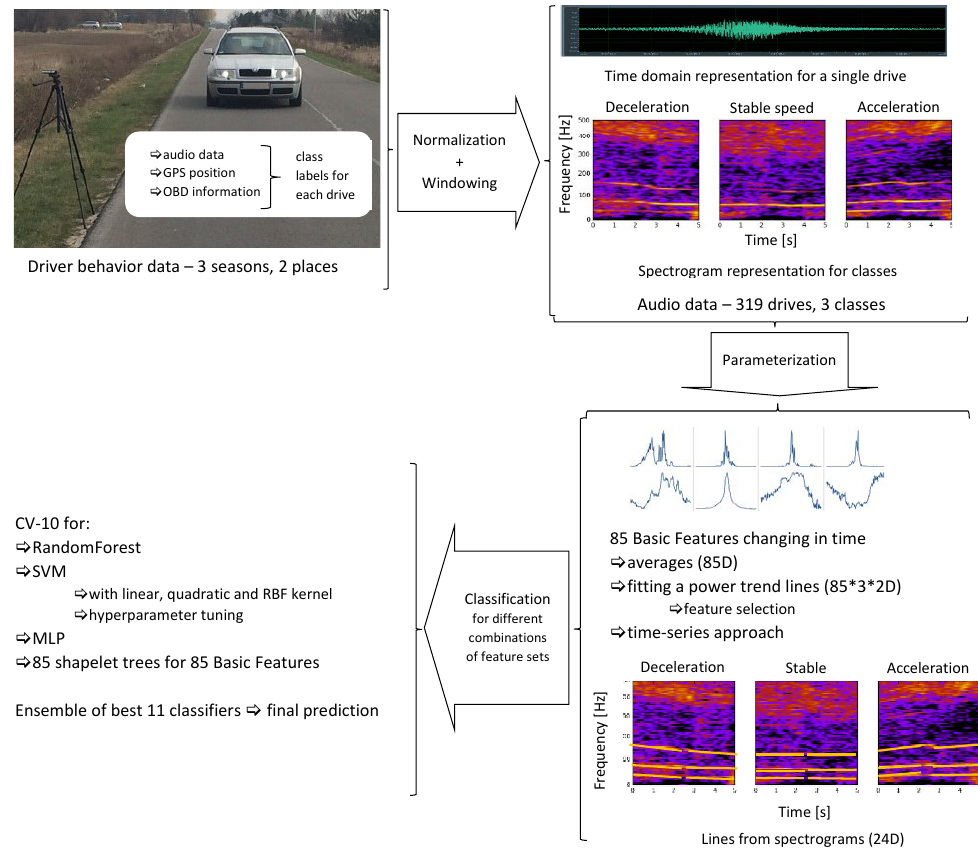
Figure 1. Our proposed methodology of research on evaluating speed changes from audio